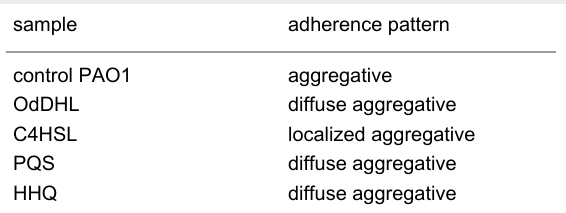
Table 1: The adherence patterns to cellular substrate of PAO1 strain treated with 20 µM purified QQSMs.